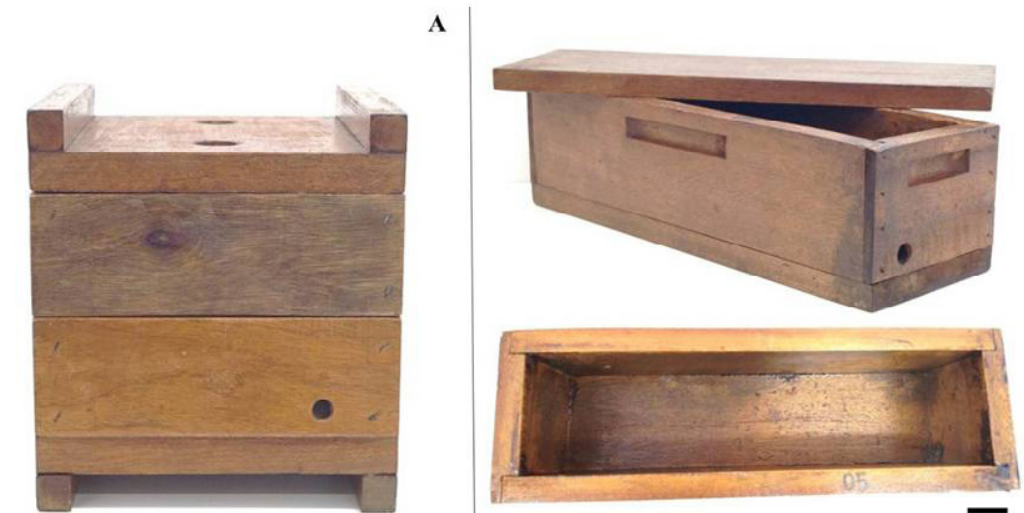
Fig 2 . (A) Vertical (Embrapa) hive model.Scale bar: 1:6.5cm. (B) Horizontal (“cabocla”) hives used in the comparison with the vertical hive. Scale bar: